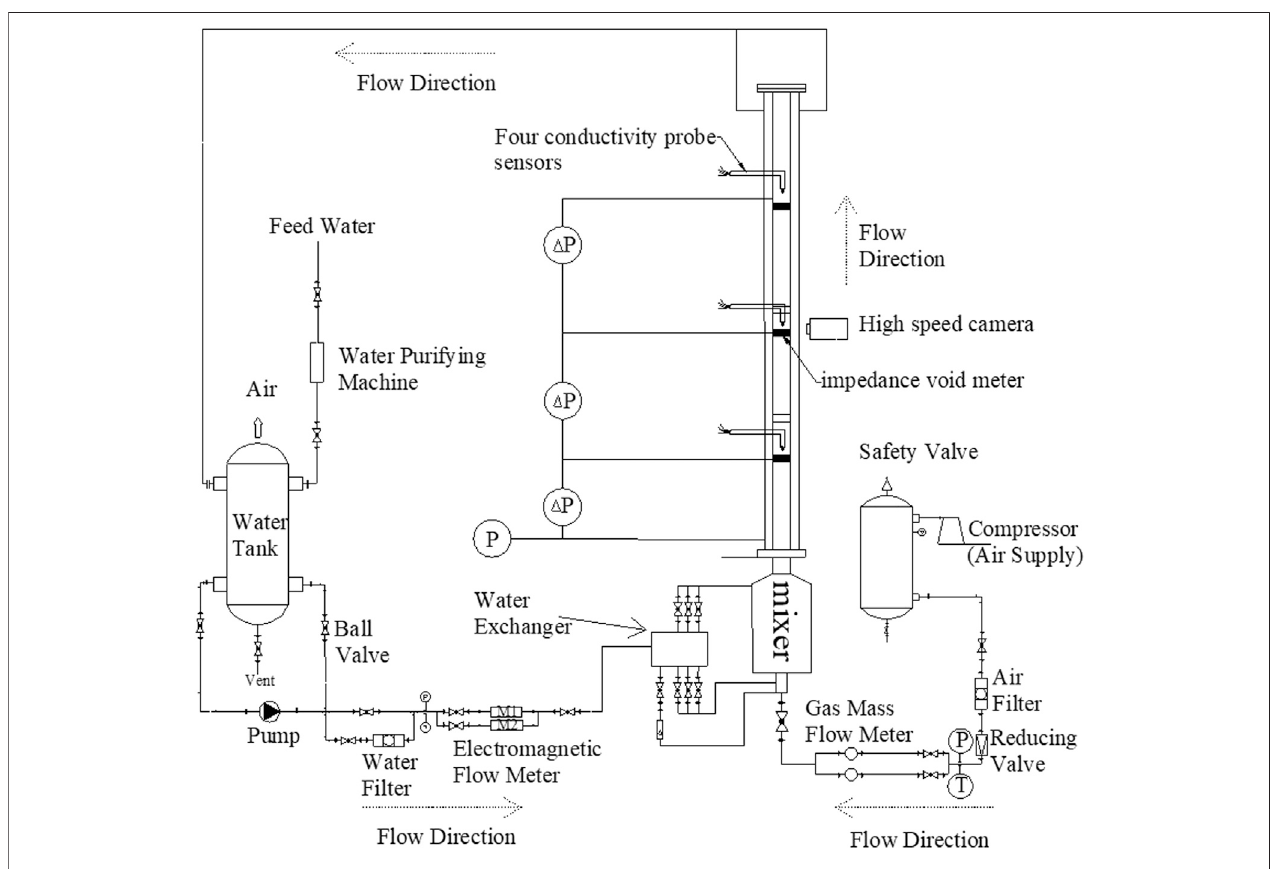
FIGURE 1 | Schematic diagram of the experimental loop system.